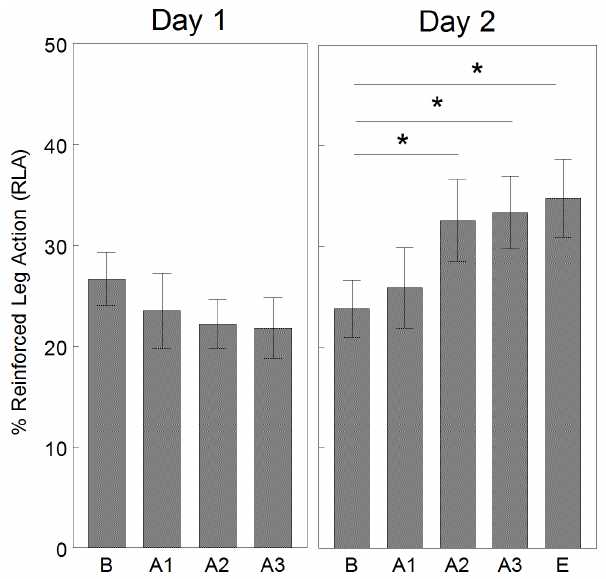
Figure 4. Mean percent reinforced leg action by interval. Infants (n=14) demonstrated improved performance on Day 2, but not on Day 1. Day 2 there was a significant difference between B and A2, A3, E. *=adjusted p , 0.05 Error bars are standard error. A=acquisition, B=baseline, E=extinction.